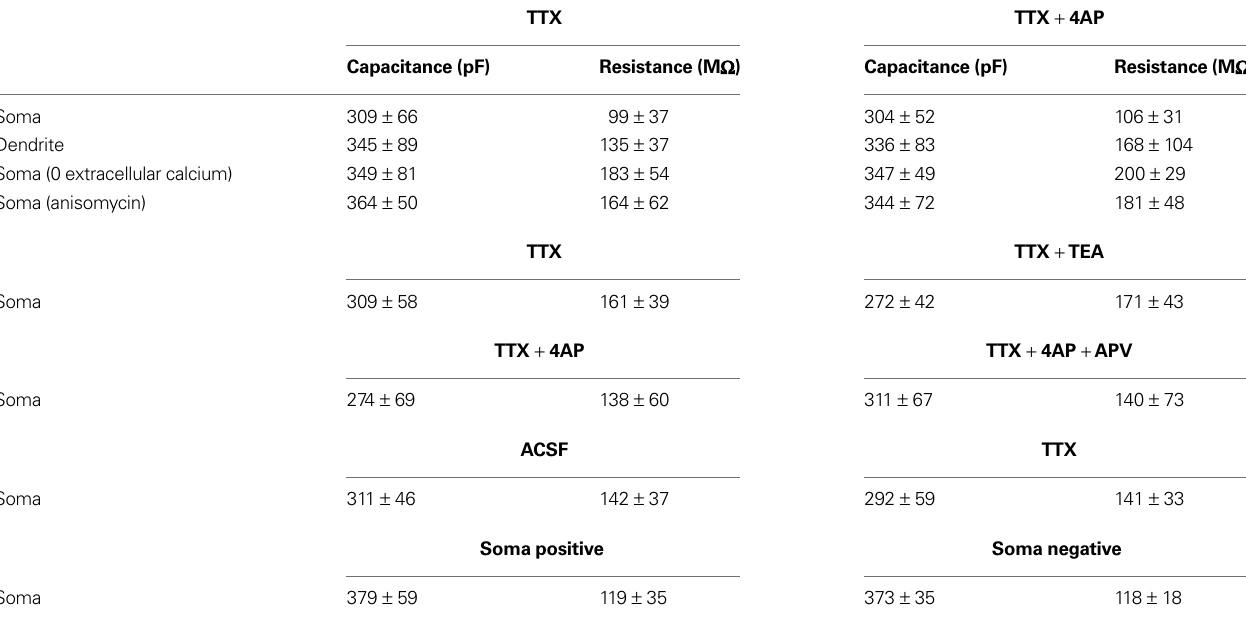
Table 1 | No signifi cant differences exist in the membrane properties of experimental groups used for the mEPSC